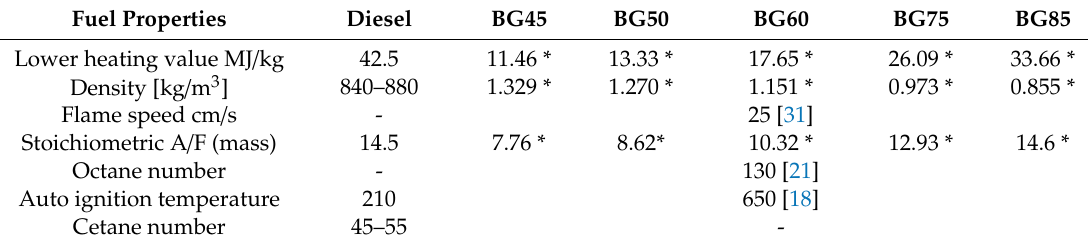
Table 3. Fuel properties.